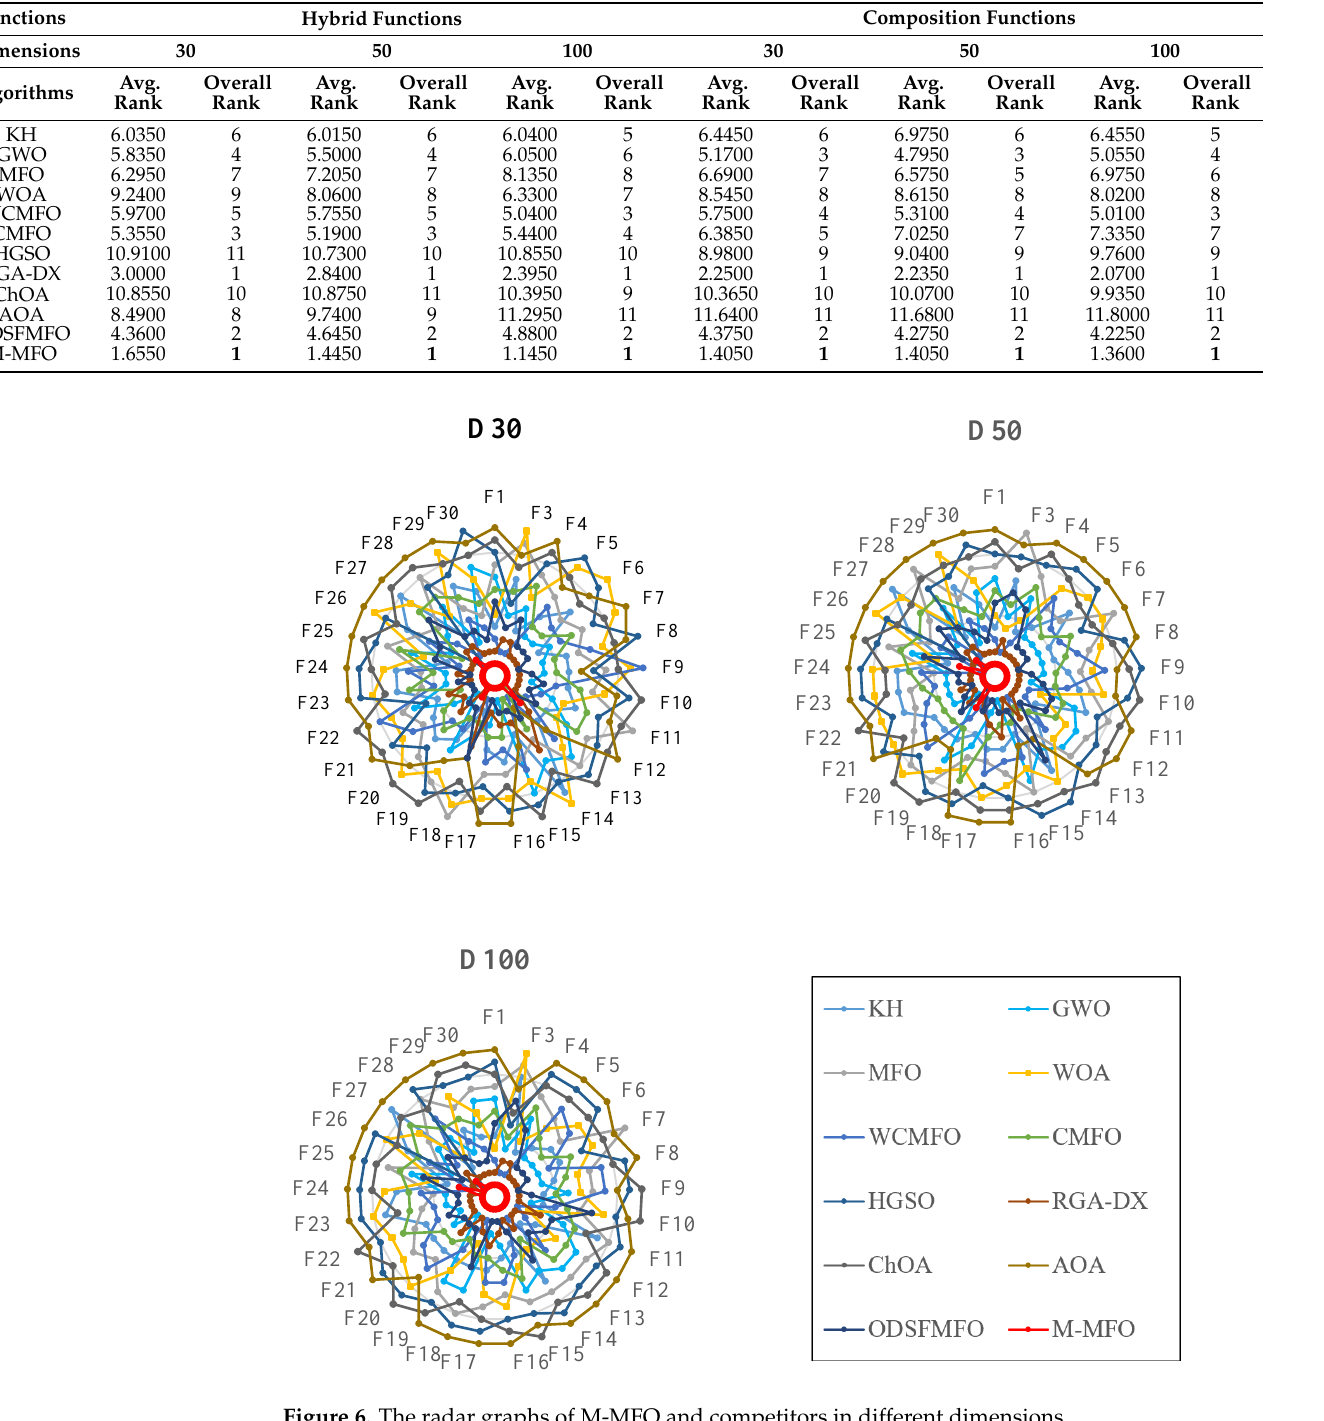
Figure 6. The radar graphs of M-MFO and competitors in different dimensions.